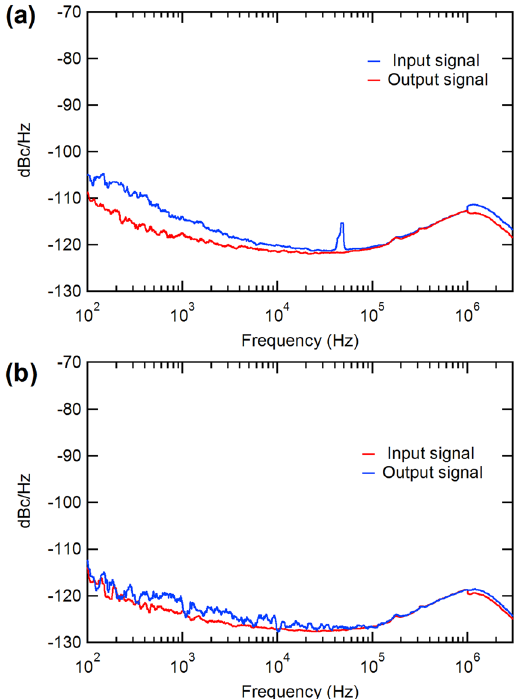
Figure 5. ( a ) Phase noise comparison between the input and output of the pulse generator. ( b ) Phase noise comparison between the input and output of the semiconductor laser diode.